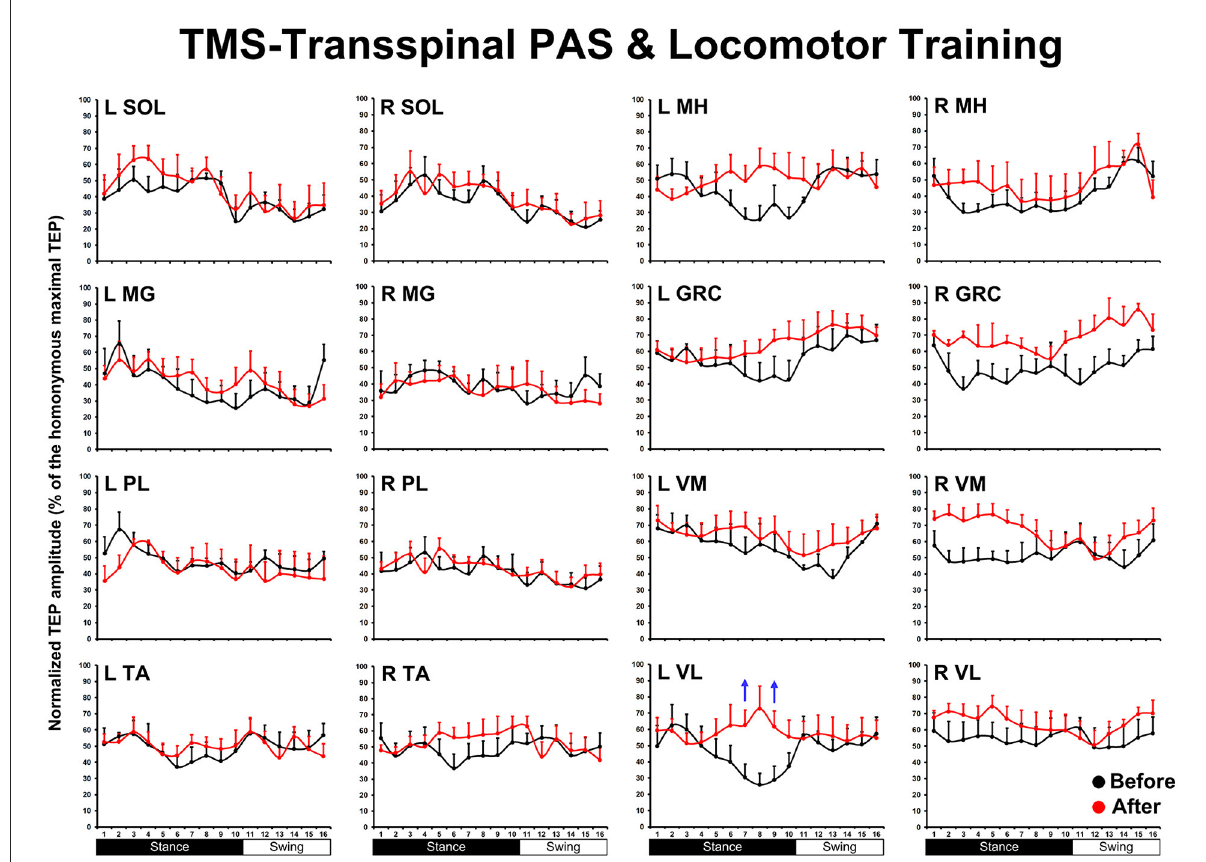
FIGURE3 The mean amplitude of TEPs, from all subjects, recorded during assisted stepping from left and right muscles before (black) and after (red) TMS-transspinal PAS and locomotor training are normalized to the maximal homonymous TEP and plotted against the step cycle divided into 16 equal bins. Red arrows indicate depression and blue arrows indicate facilitation. Error bars indicate the SEM. SOL, soleus; MG, medial gastrocnemius; PL, peroneus longus; TA, tibialis anterior; MH, medial hamstring; GRC, gracilis; RF, rectus femoris; VL, vastus lateralis; TMS, transcranial magnetic stimulation; PAS, paired associative stimulation; TEPs, transspinal evoked